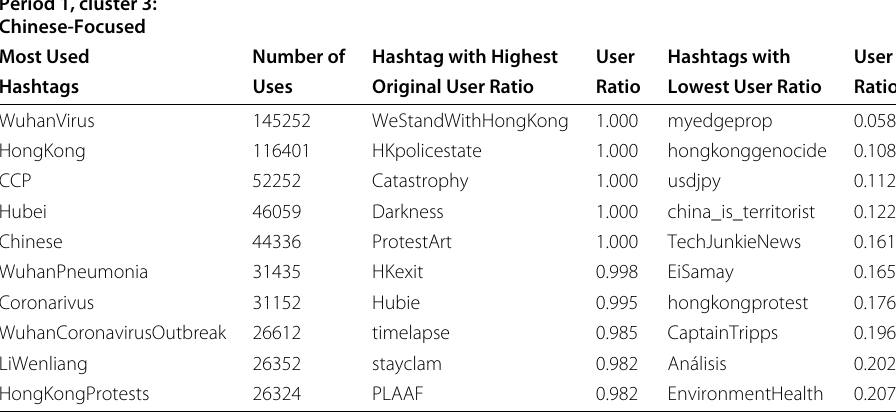
Table 3 Top raked hashtags from period 1, cluster 3 which is Chinese-focused in its hashtags Period 1, cluster 3: Chinese-Focused